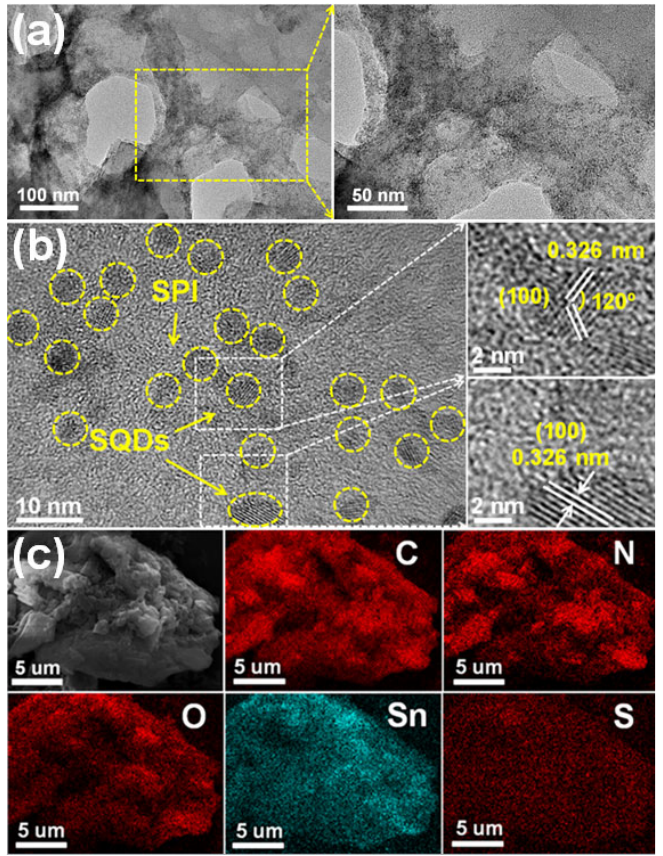
Figure 2. ( a ) TEM, ( b ) HR ‐ TEM, and ( c ) SEM and elemental mapping images of 10SQDs/SPI composite sample.